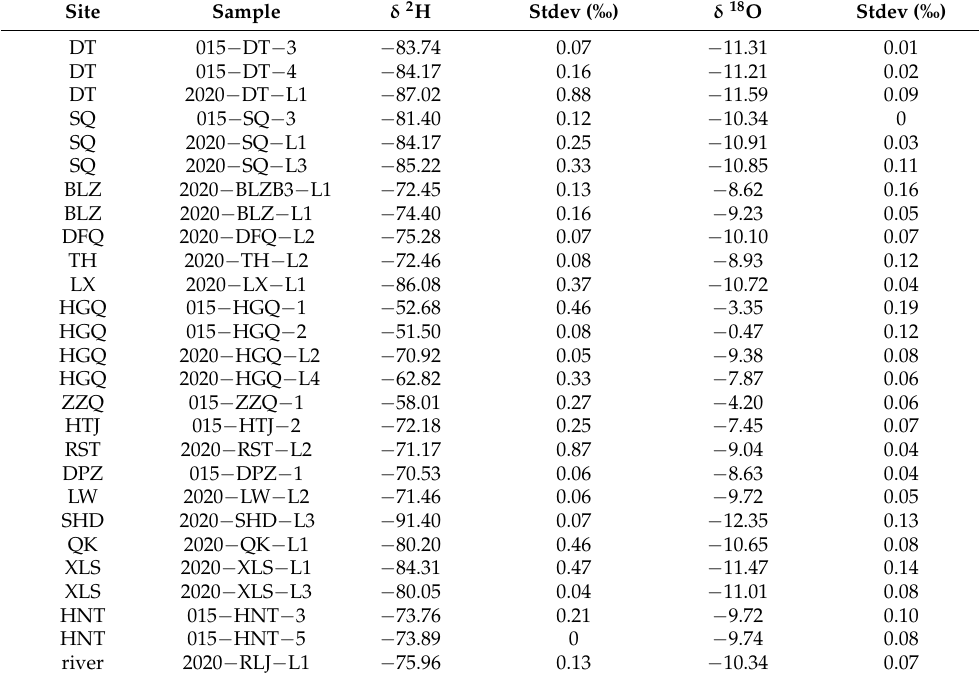
Table 1. The stable hydrogen and oxygen isotope compositions of the Tengchong hydrothermal fluids.